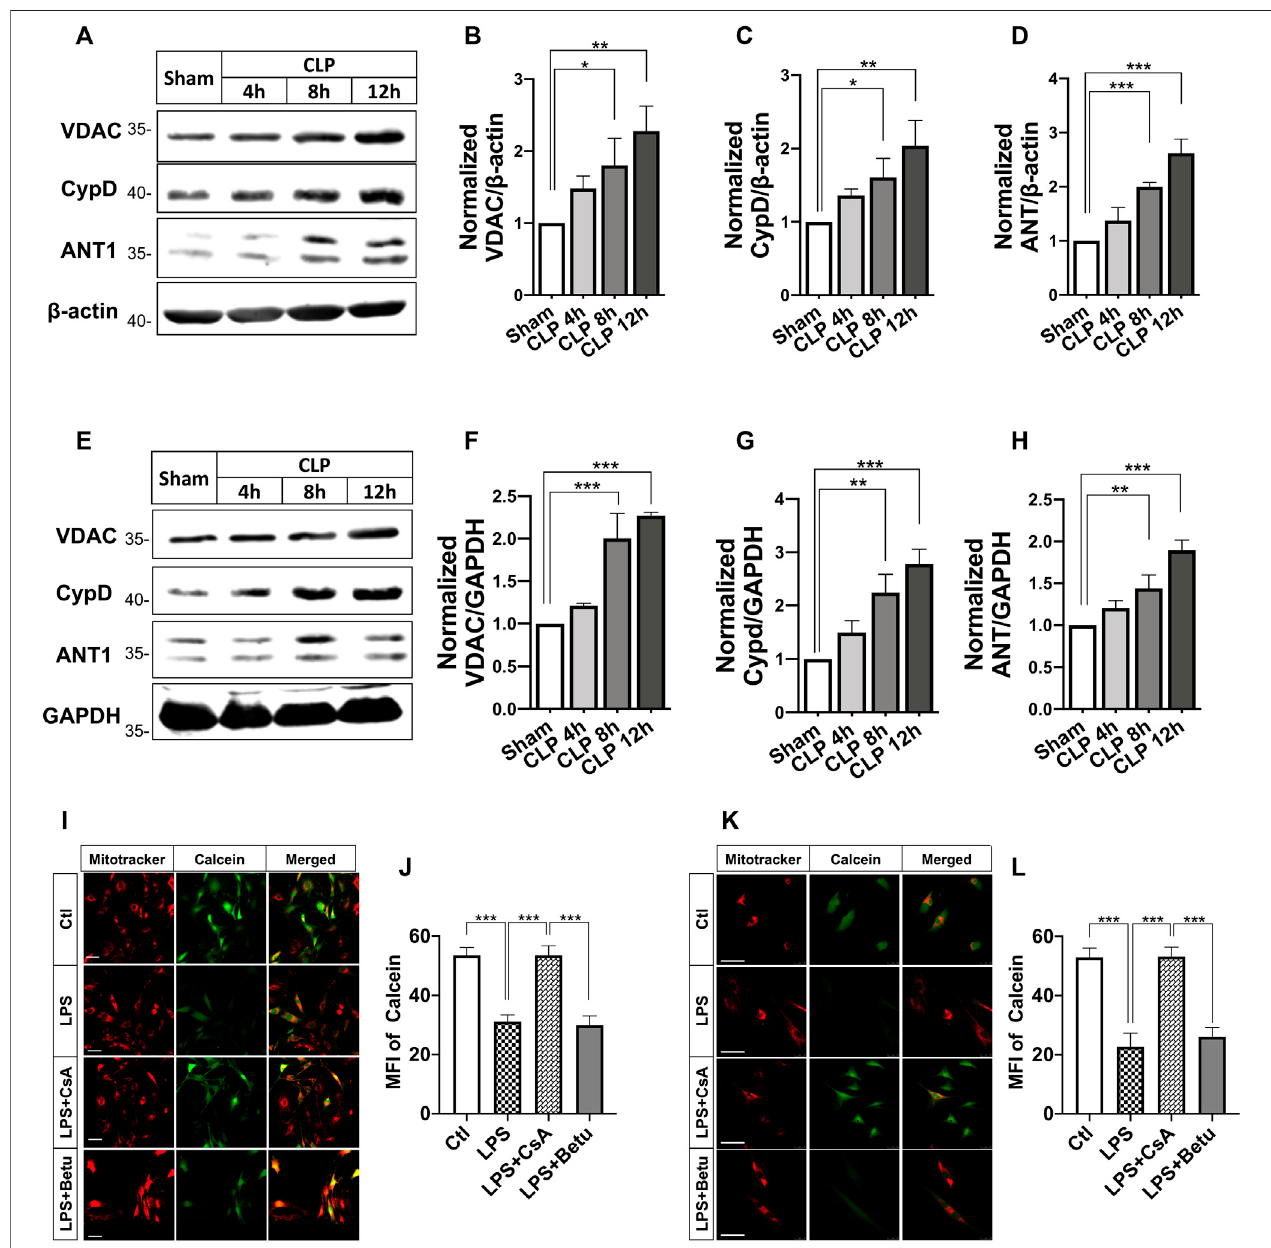
FIGURE 4 | Effects of CsA on mPTP opening after septic shock in rats. (A-C) , expression of voltage-dependent anion channel (VDACs) and cyclophilin-D (CypD) and adenine nucleotide translocase (ANT) in the superior mesenteric artery (SMA) from septic-shock rats ( n (cid:1) 3); (E-H) , Expression of voltage-dependent anion channel (VDACs) and cyclophilin-D (CypD) and adenine nucleotide translocase (ANT) inthe cardiac papillarymuscle(CPM) from septic-shock rats( n (cid:1) 3); (I-L) ,mPTP opening in VSMCs and H9C2 cardiomyocytes ( n (cid:1) 20/group from 3 independent experiment). Scale bar (cid:1) 50 μ m. CLP, cecal ligation and puncture; CsA, cyclosporine A; Betu, betulinc acid; LPS, lipopolysaccharide; MFI, mean fl uorescence intensity. * p < 0.05, ** p < 0.01, *** p < 0.001; ns , not signi fi cant.